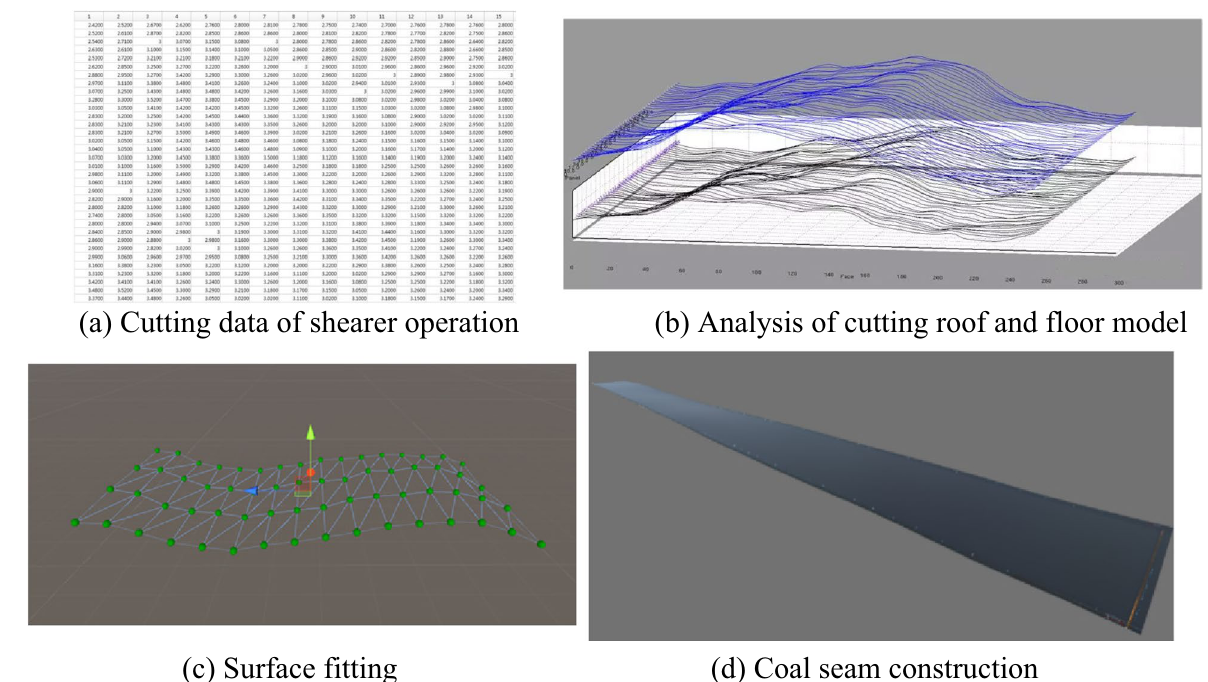
Fig. 7 Established coordinate system for the working